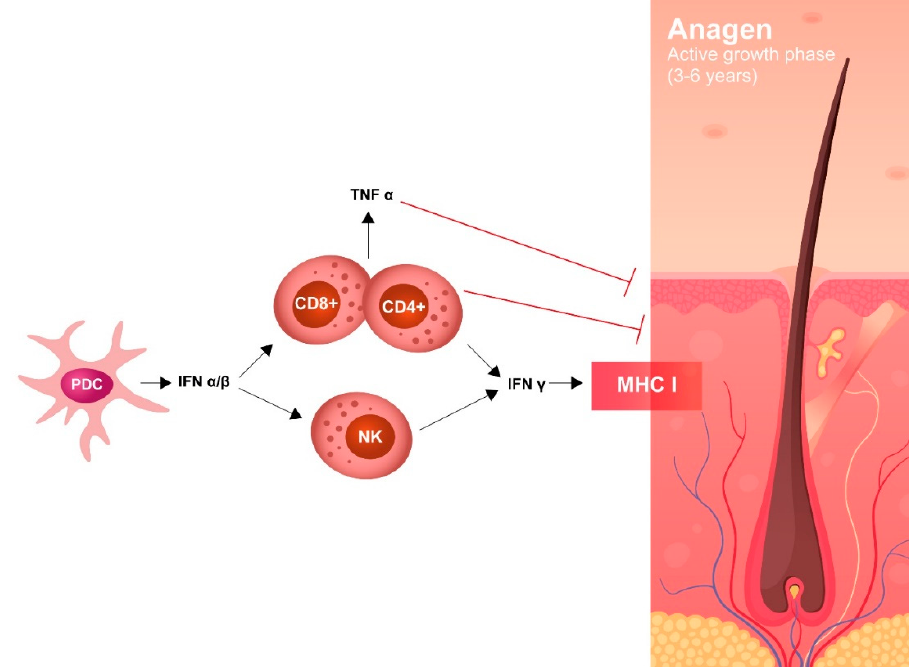
Figure 5. Pathogenesis of IFN-induced alopecia.